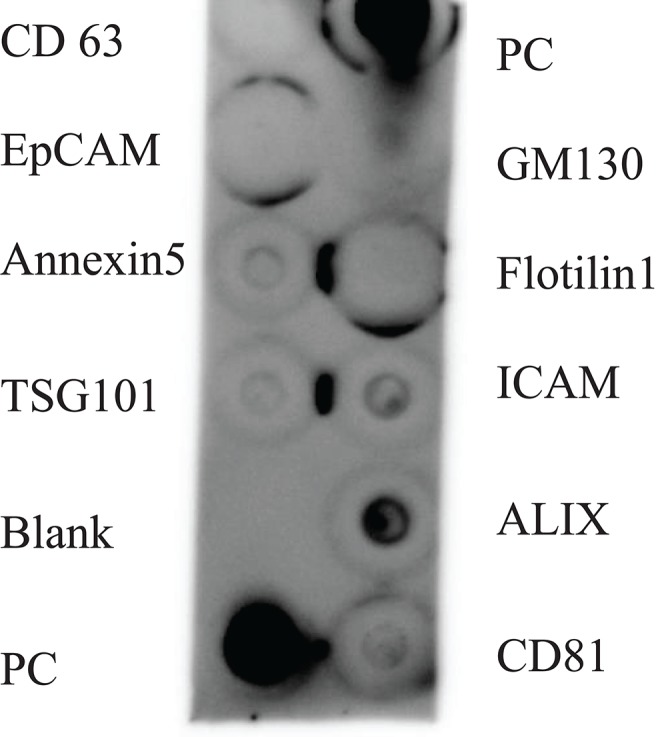
Antibody array of human milk EVs from participant (n = 1). PC represents the positive control, and GM130 is a cellular contamination marker. CD 63 = cluster of differentiation 63, EpCAM = epithelial cell adhesion molecule, TSG101 = tumor susceptibility gene 101, ICAM = intracellular adhesion molecule, ALIX = ALG-2-interacting Protein X, CD81 = cluster of differentiation 81.